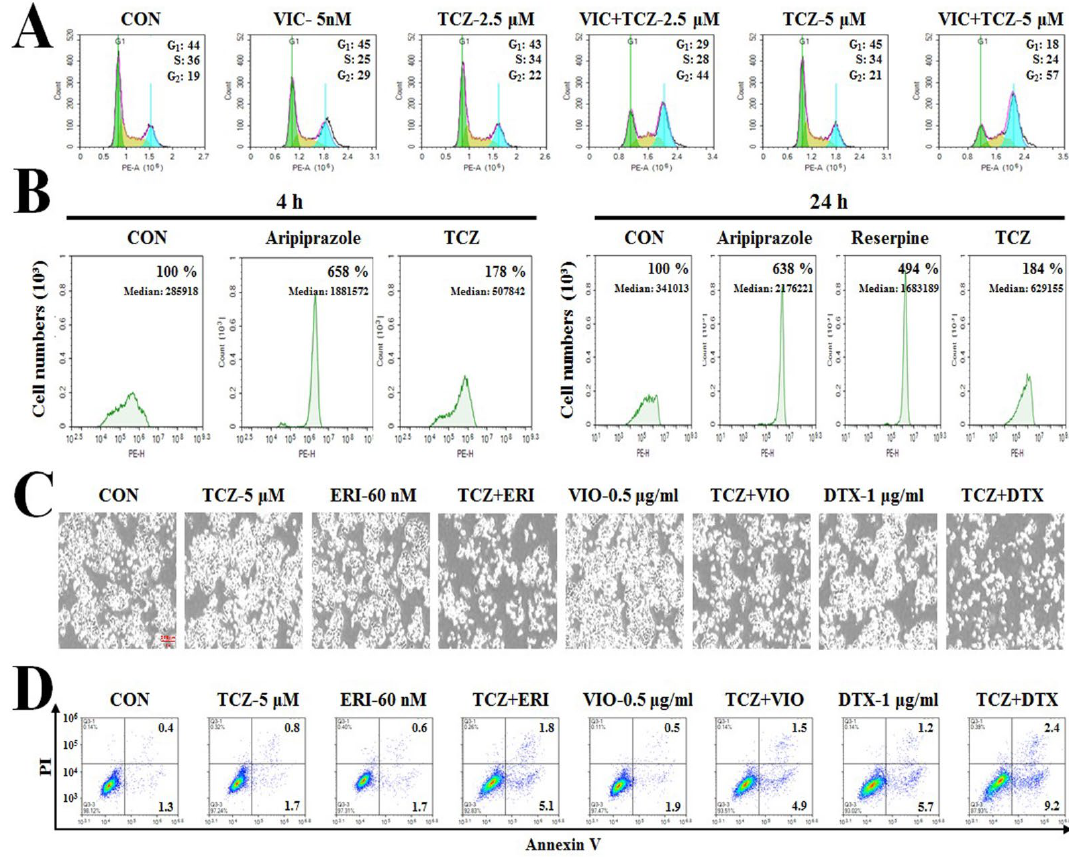
Figure 3. Co-treatment with TCZ increases cytotoxicity toward other antimitotic drug-treated KBV20C cells. ( A ) KBV20C were treated with 5 nM VIC, the indicated μM concentrations of TCZ alone, or in combination with 5 nM VIC, or 0.1% DMSO (CON). After 24 h, FACS analyses were performed as described in Materials and Methods. ( B ) KBV20C cells were treated with 2.5 μM aripiprazole, 2.5 μM reserpine, 5 μM TCZ, or 0.1% DMSO (CON). After 1 h (left panel) or 21 h (right panel), all cells were stained with rhodamine 123 for 3 h and examined by using FACS analysis as described in Materials and Methods. ( C and D ) KBV20C cells treated with 5 μM TCZ, 0.5 μg/mL vinorelbine (VIO), 60 nM eribulin (ERI), 1 μg/mL docetaxel (DTX) alone, or in combination with 5 μM TCZ, or 0.1% DMSO (CON). After 24 h, all cells were observed using an inverted microscope at ×40 magnification ( C ), or annexin V analyses ( D ) were performed.